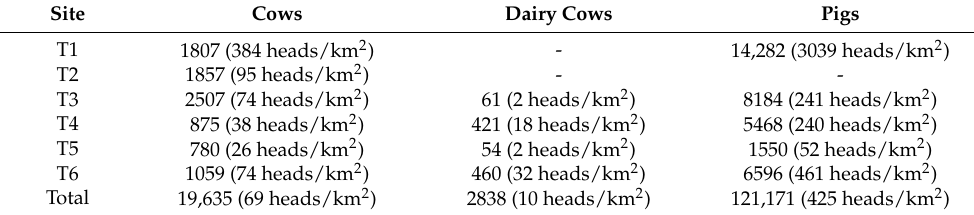
Table 1. Number of Livestock in 2019.